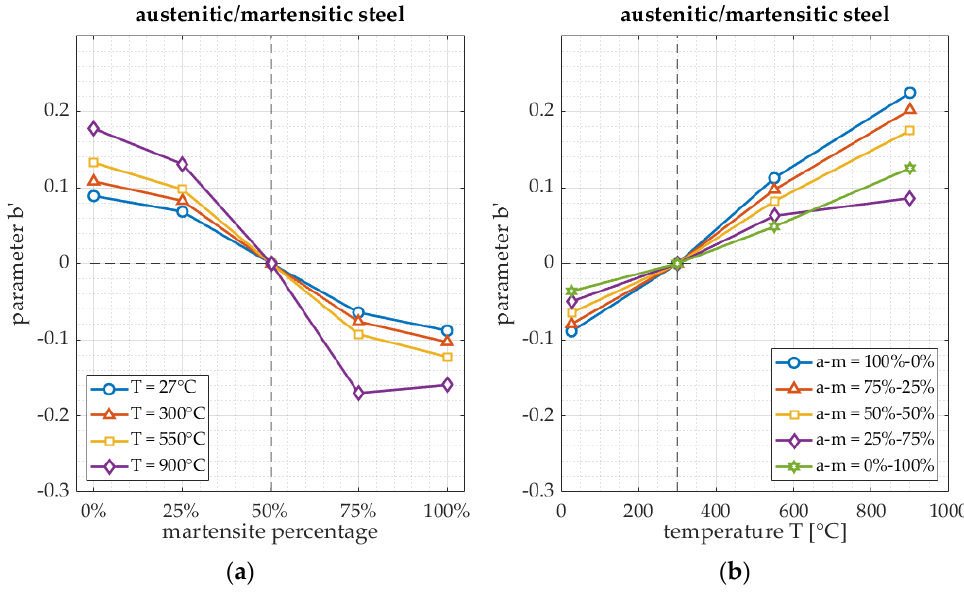
Figure 18. ( a ) The relation between the phase ratio and parameter 𝑏′ for austenite/martensite for the four temperatures; and ( b ) between temperature and parameter 𝑏′ .